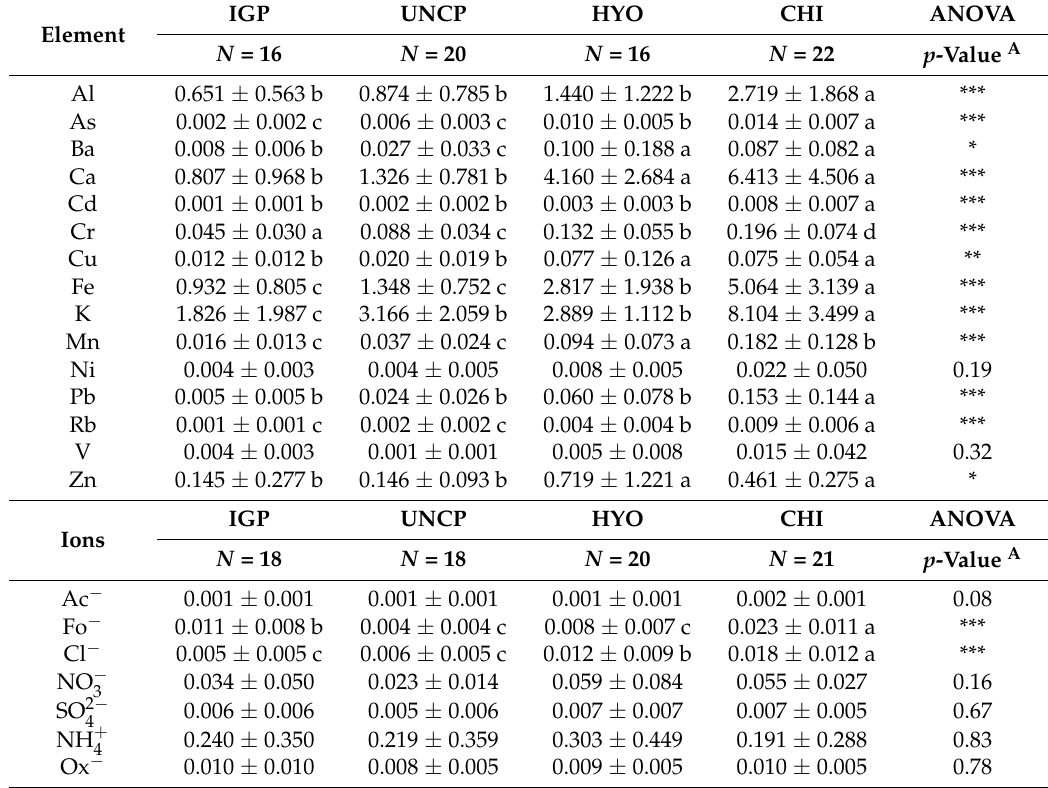
Table 4. Comparison of mean concentration values ( ± standard deviation, SD) in µ g m − 3 and results of the analysis of variance (ANOVA) of the trace elements and water-soluble ions measured in PM 2.5 collected at each monitoring station from the Metropolitan area of Huancayo city, Jun í n,